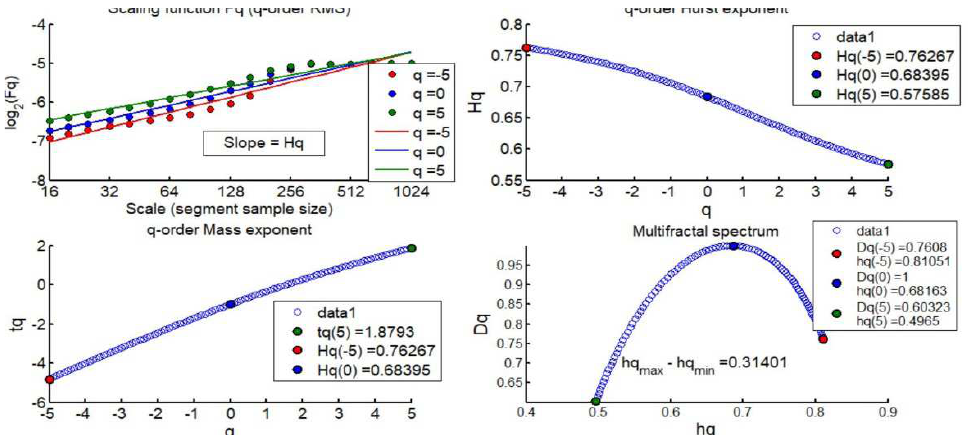
Figure A6. Hurst exponent value Hq (5) in